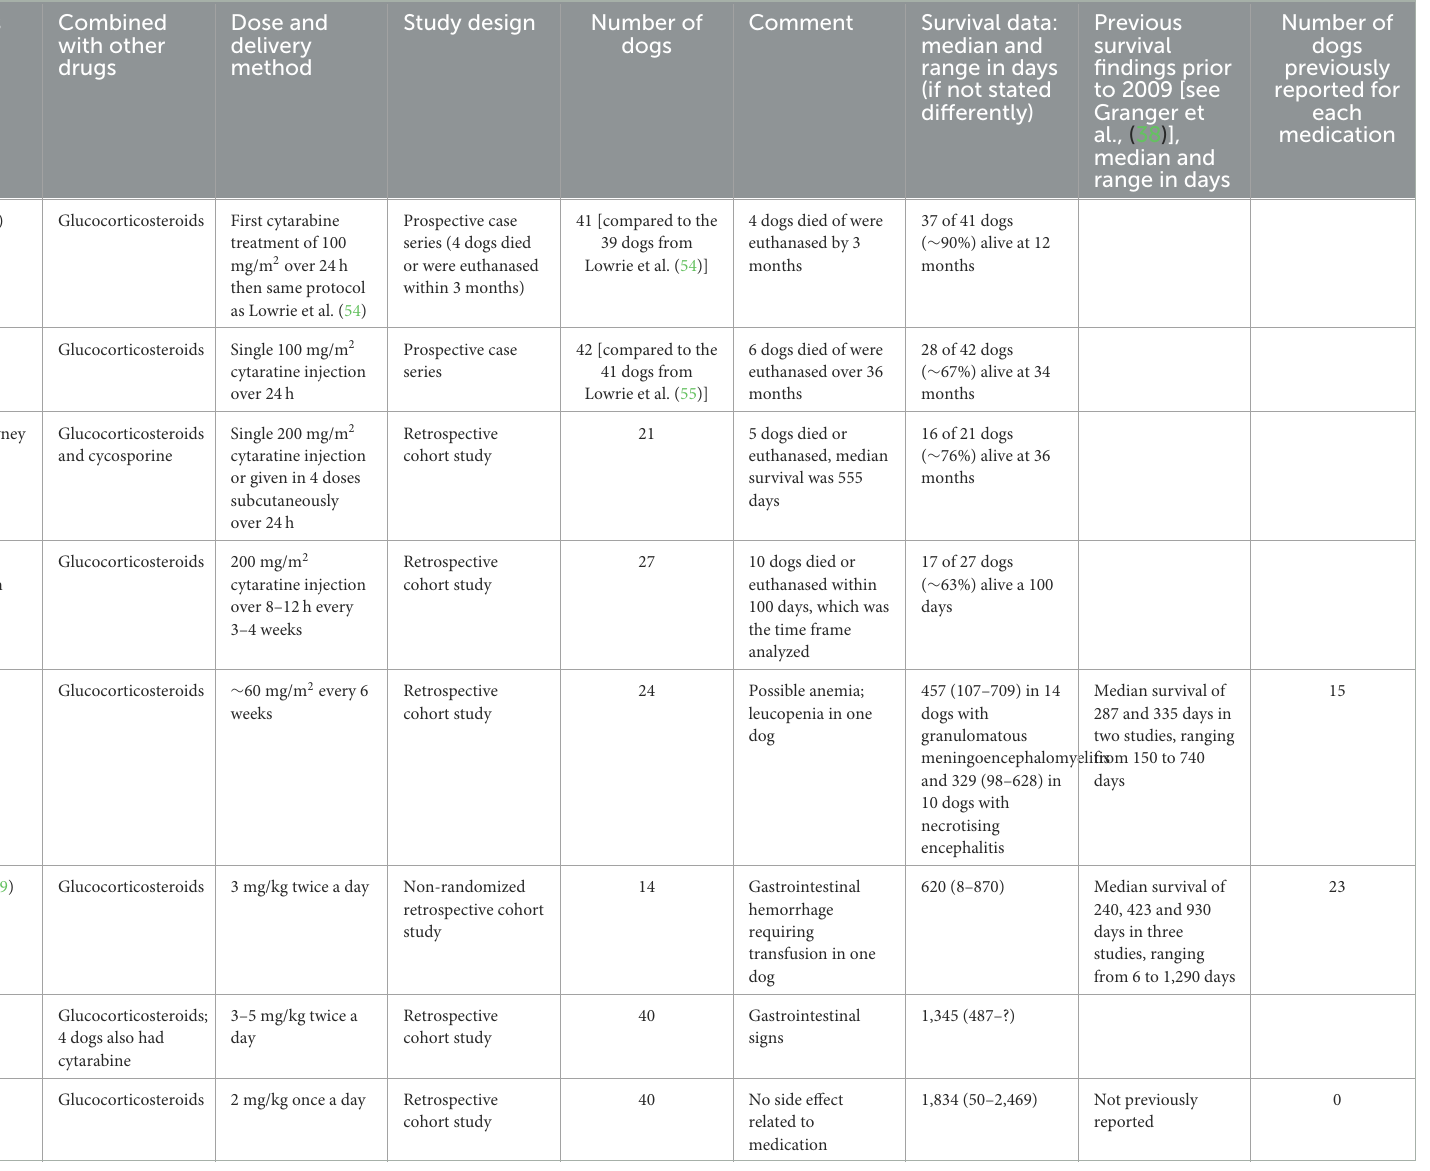
A point of comparison is provided in the far right last two columns: in these are reported the median (and range) survival obtained from our previous review and extracted from publications available before 2009 to provide comparison with survival times reported